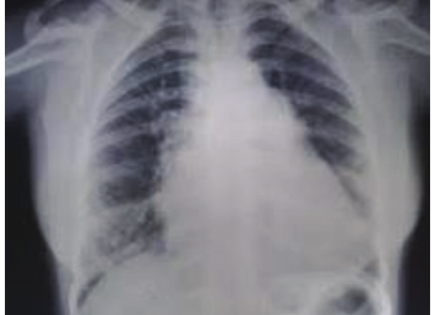
Figure 2: Cardiomegaly and increased pulmonary vascular mark- ings.